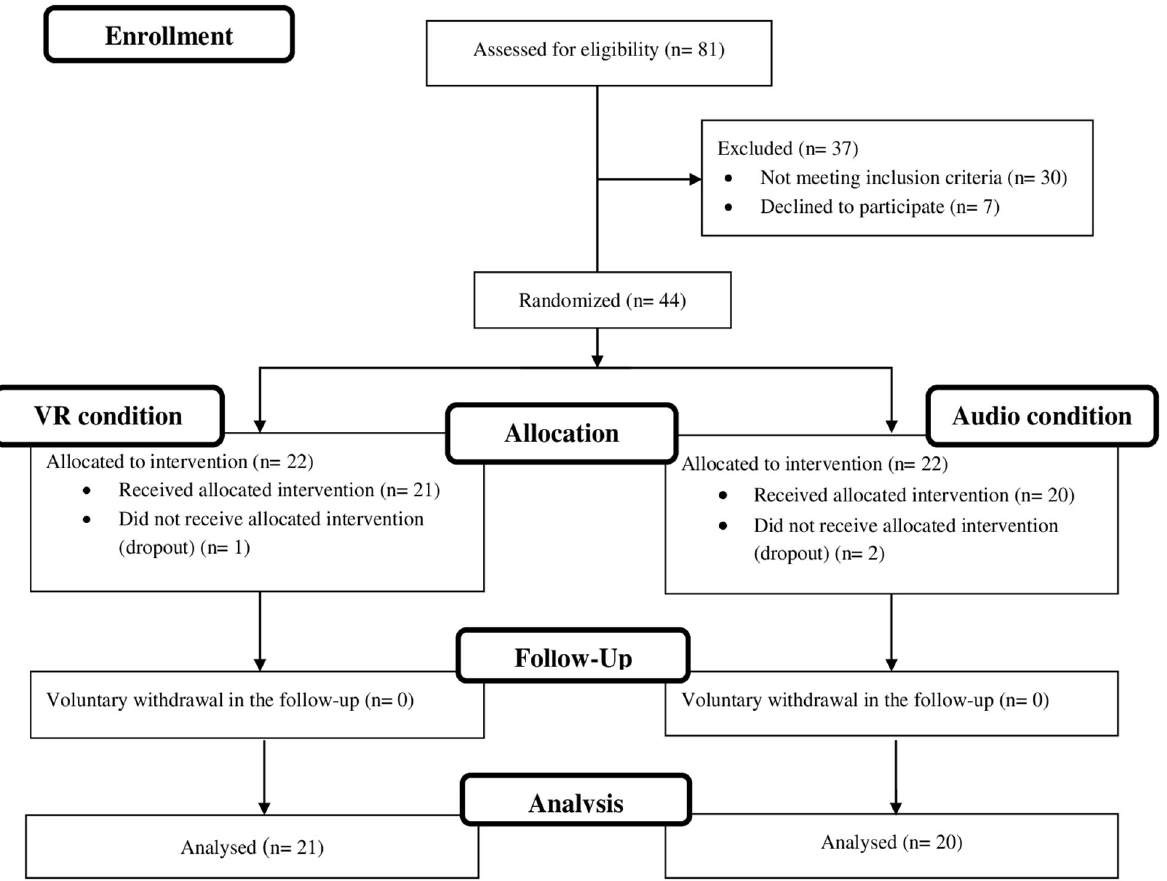
Figure 1. Participants’ flow diagram.